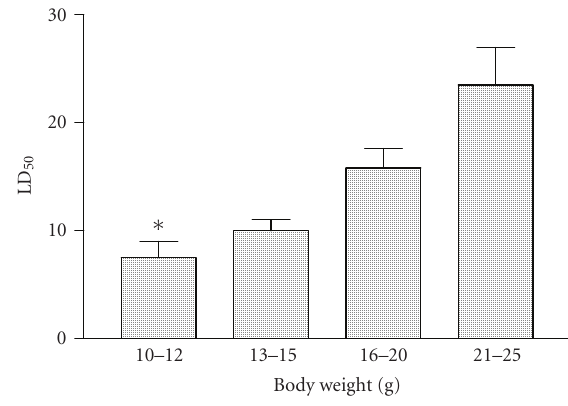
Figure 1: E ff ect of Cdt according to body weight . Groups of 10 BALB/c female mice with di ff erent body weight were i.p. injected with di ff erent amounts of Cdt. Deaths occurring during 24 hours were recorded and the LD 50 value was calculated. Statistical di ff erence between the groups were marked with asterisk ( P < .